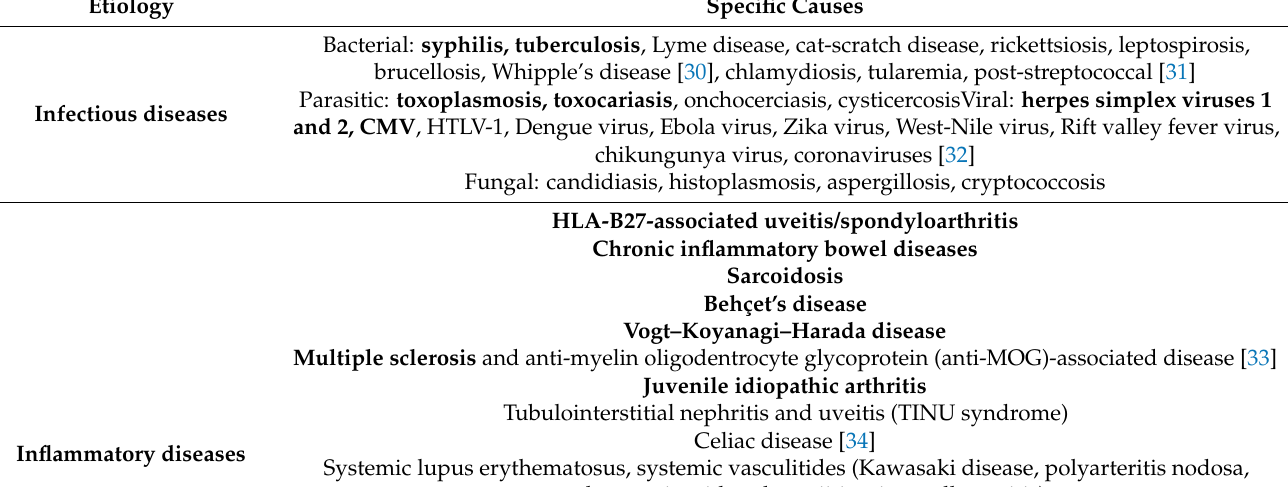
Table 1. Main causes of uveitis in adults (From S è ve et al., Autoimmun. Rev. , 2017). The most common causes (>0.5%) reported in most recent European series are indicated in bold type [21–29]. Etiology Specific